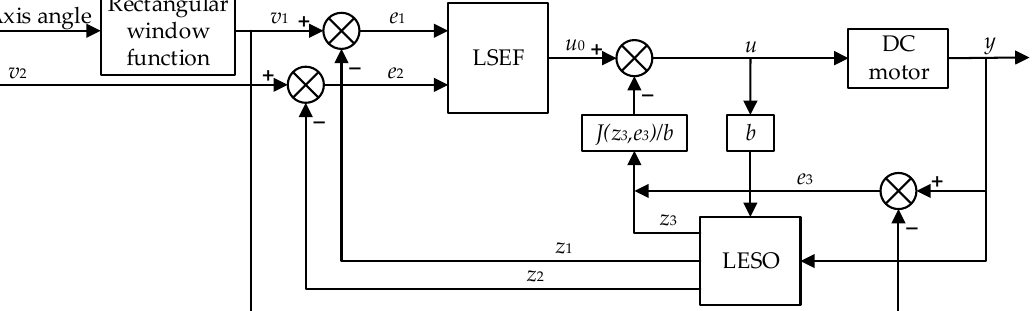
Figure 3. Stabilization block diagram of the improved linear active disturbance rejection control (LADRC) control, where θ and y are measured by inertial measurement units (IMUs), respectively. One of them is fixed on the camera and the other is fixed on the head of the shark-like robotic fish.